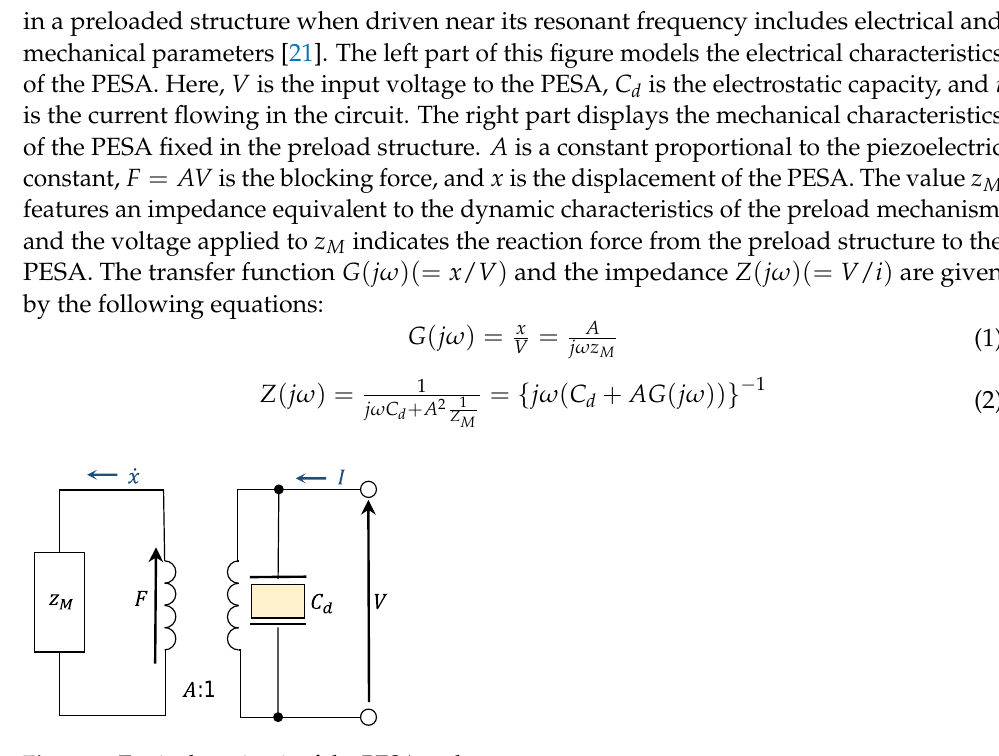
Figure 6. Equivalent circuit of the PESA and measurement system.